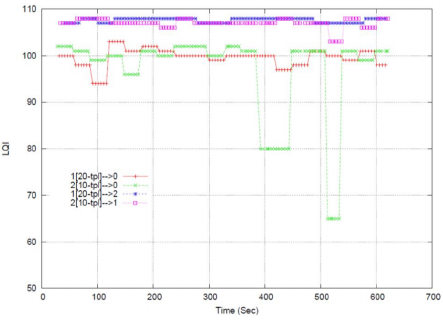
Figure 3. Link Quality vs. time and TPL